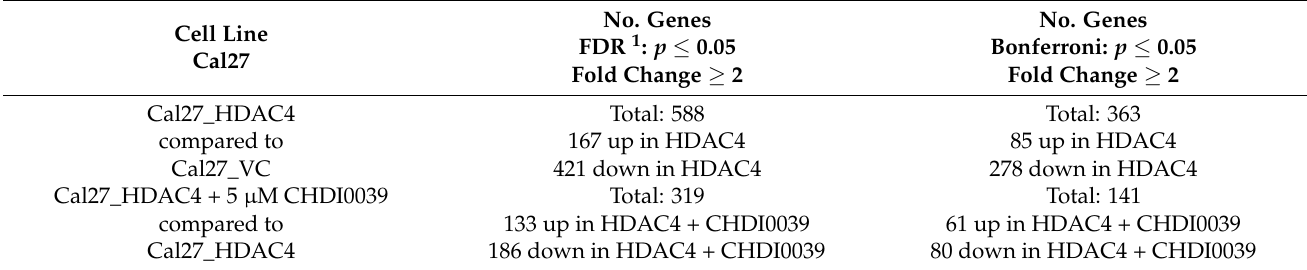
Table 1. Differentially expressed genes associated with HDAC4 expression status and class IIa HDAC inhibition by 5 µ M CHDI0039. Shown are the total number of differentially expressed genes (upper number) and the number of upregulated (up)- or downregulated (down) genes.